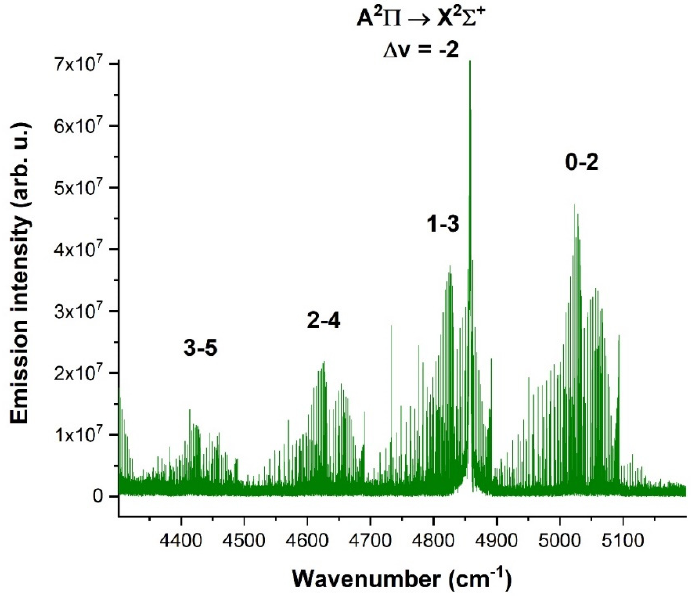
Figure 24. Spectrum of electronic bands of CN radical for the ∆ v = − 2 sequence (36 µ s). Figure 25 shows the spectrum of the CN radical in the spectral region of 6400–7100 cm − 1 , where the ∆ v = − 1 sequence is located and was obtained by the use of a cyanogen- helium